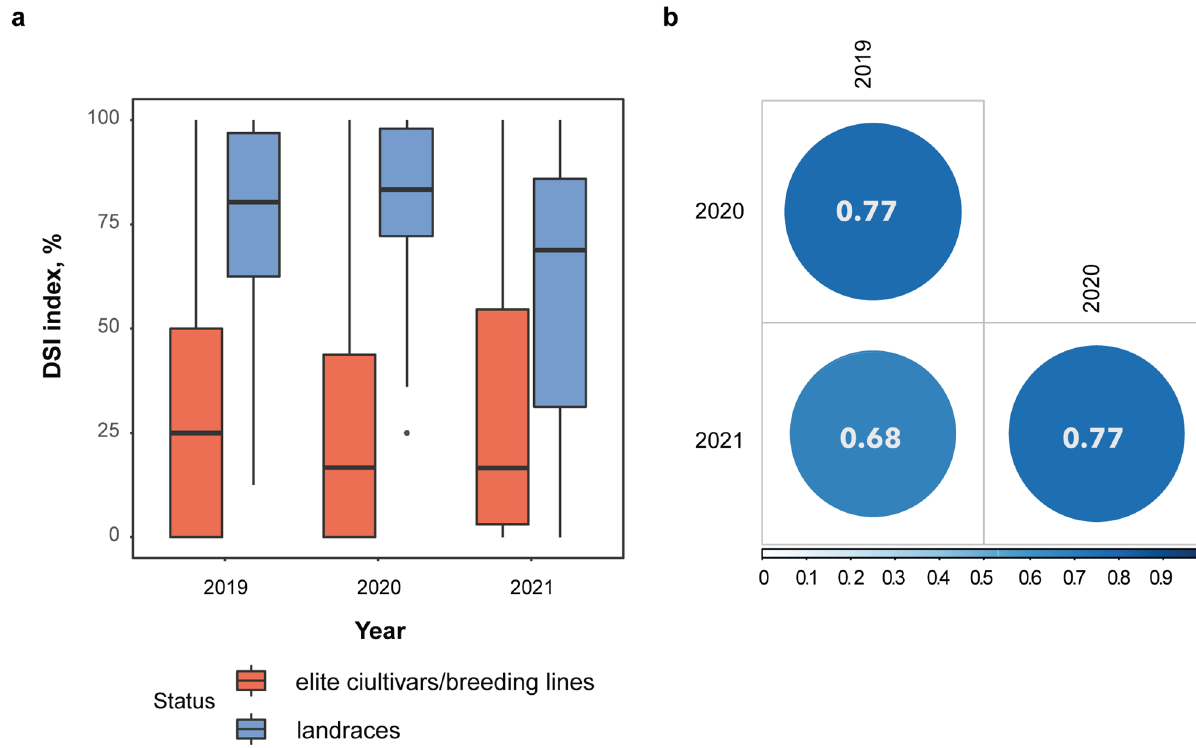
Figure 1. Fusarium wilt resistance in the dataset. ( a ) DSI index values in elite cultivars/breeding lines and landraces. Black dots represent outlier values, ( b ) The between year correlation of DSI index.